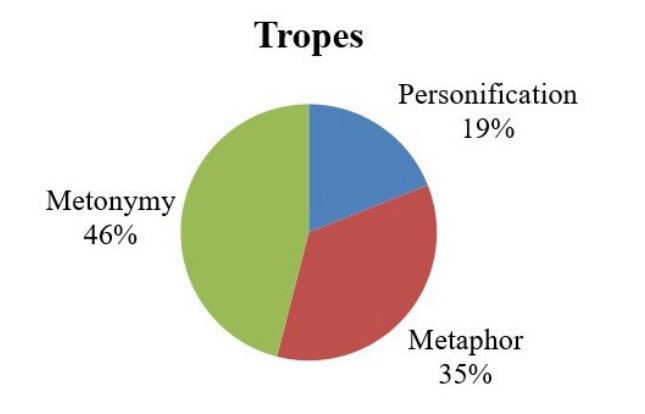
Figure 3 - Tropes to express negative evaluation in sports reporting DOI: